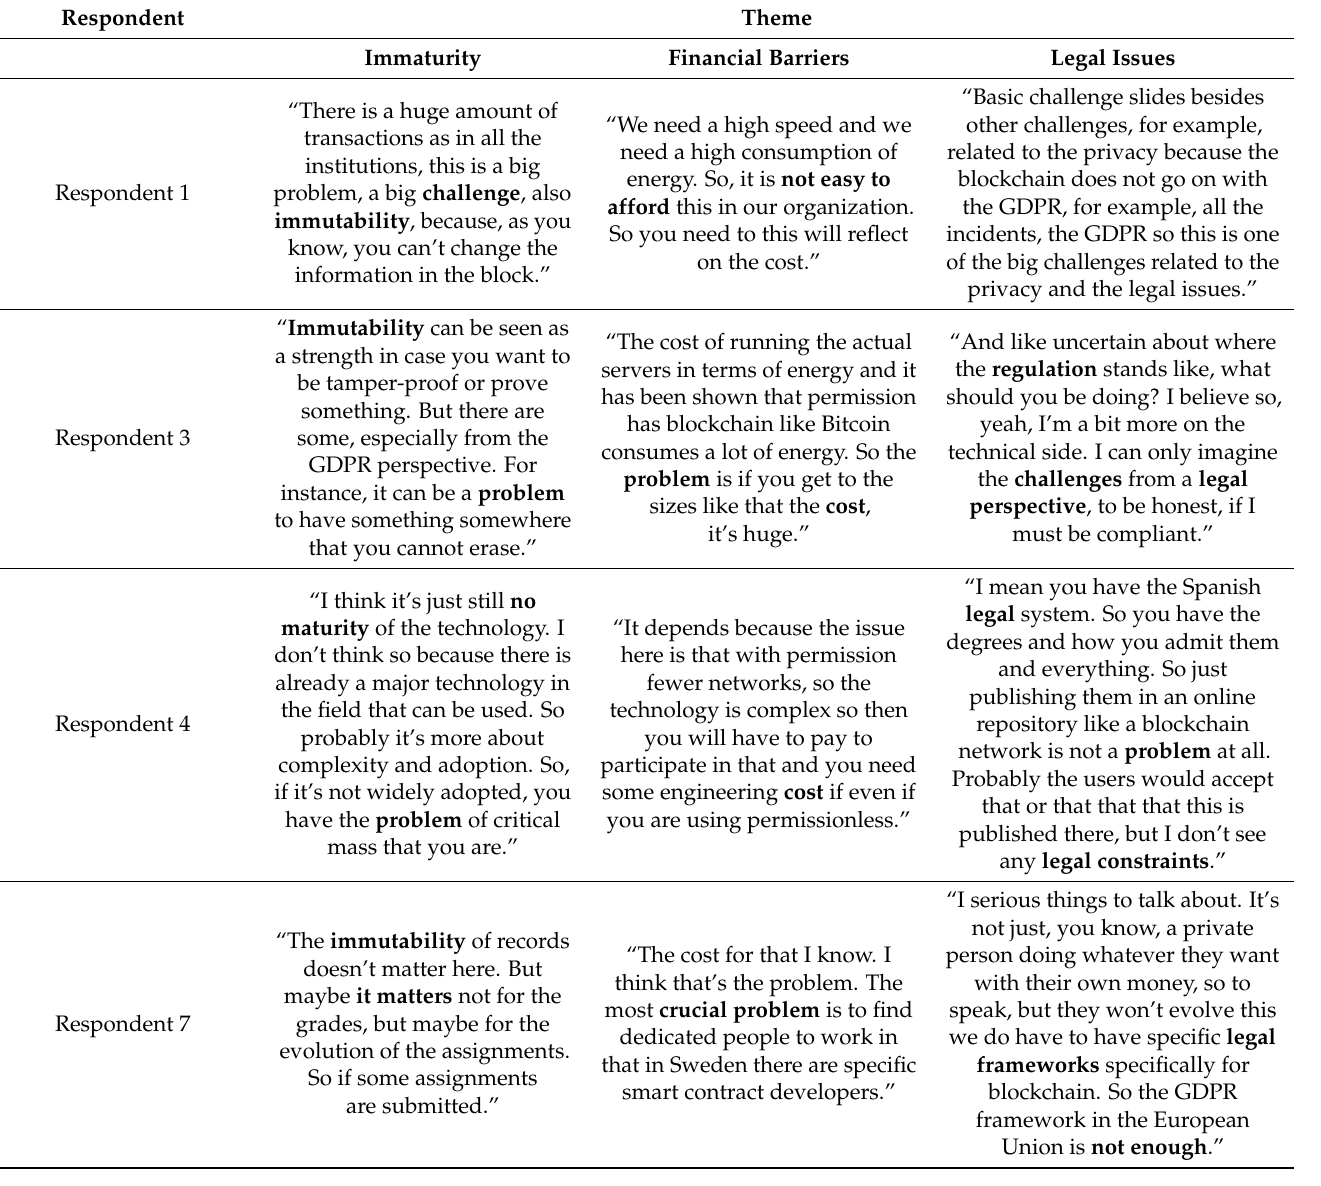
Table A1. Sample of